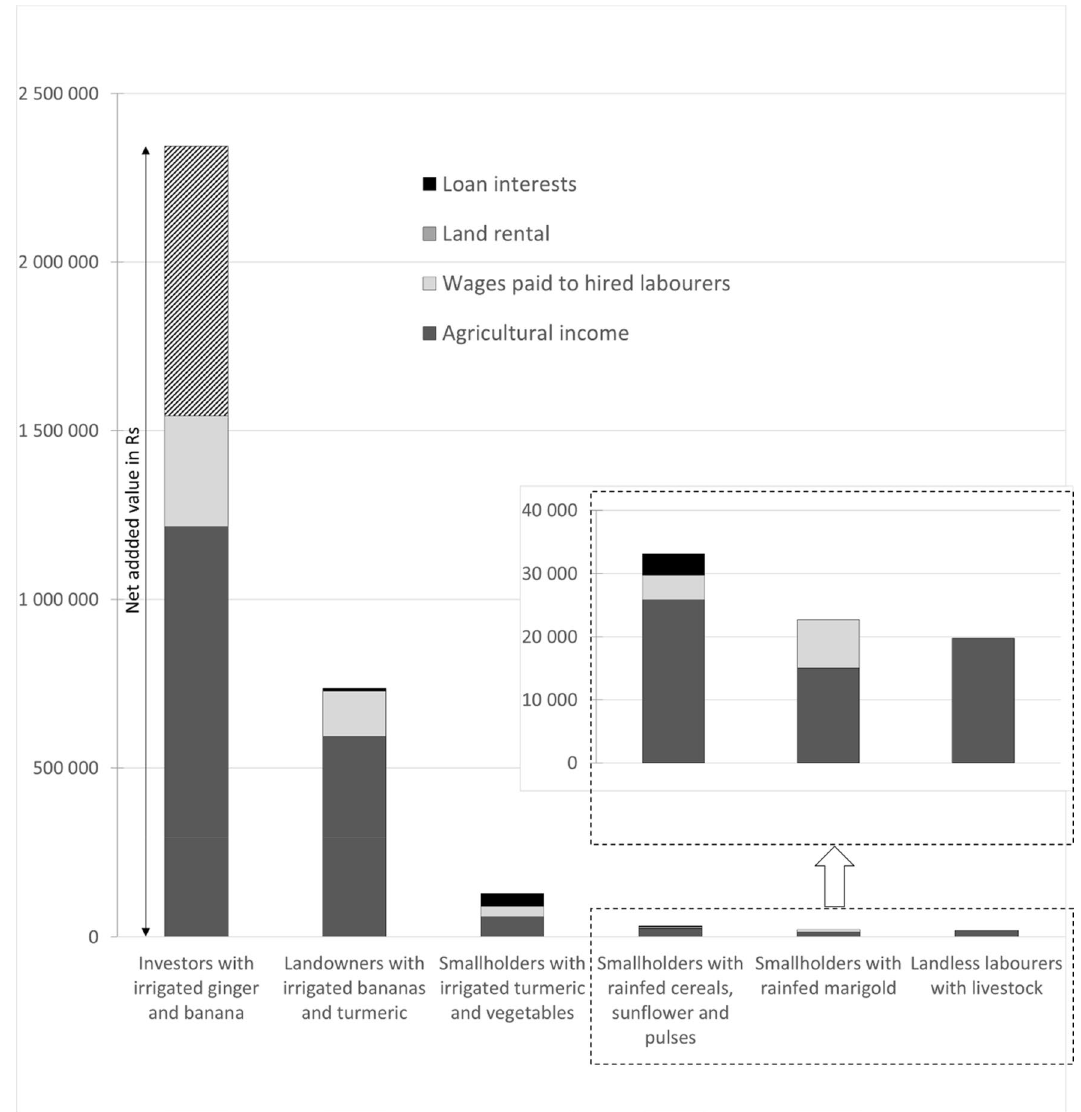
Figure 3. Distribution of net value added and resulting agricultural income for 6 production systems, in Indian Rupees (Rs) per family worker or per owner per year. The Y axis for the 3 production systems on the right is expanded in the inside plot to allow visualizing the distribution of the net value added. Exchange rate with US Dollar (USD) was 1 USD = 67.5 income) and from their agricultural labour which they sell to irrigating farmers (17% of their total income), and altogether they earn an income close to the poverty threshold (Table 2). Non-irrigating smallholders in the Western zone (PS5) have not yet invested in irrigation, which developed later in this part of the study area. The slightly more humid climate allows them to cultivate rainfed maize and marigold with better and more stable yields and marginally higher productivities than for the rainfed cropping systems in the Eastern zone (with the exception of marigold, with a labour-intensive harvest and hence low labour productivity, Table 1). Difficulties in accessing fodder and competition between activities for the use of labour force led them to abandon livestock farming. Agricultural labour wages thus play a more important role in their livelihoods (more than fifty per cent of the total income, which is also close to the poverty threshold, Table 2). The majority of the landless labourers with livestock (PS6) have never owned land and work on other people’s farms as day labourers. Benefitting from the development of the milk collection scheme, they set up a small dairy herd which they feed on grazing land, with spontaneous collected fodder and purchased straw and concentrate. This livestock activity is labour intensive, but with the recent changes in irrigated agriculture, it is more secure than the local sale of daily labour, and also limits the need to migrate to more distant destinations such as plan- tations in Kerala. For these landless workers, livestock farming represents over half their total income, which is equal to the poverty threshold (Table 2).